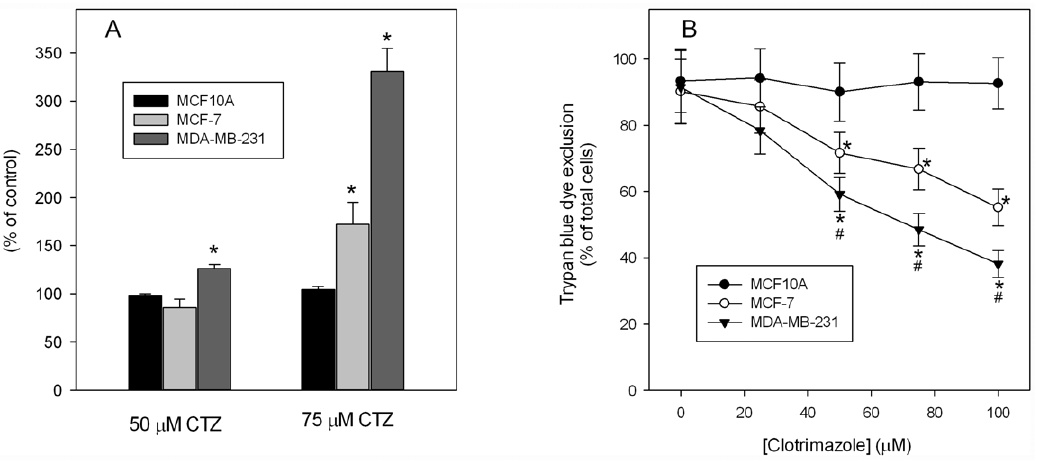
Figure 5. Cellular viability decreases in breast cancer cells treated with clotrimazole. Data are presented as mean 6 SE of at least five experiments. Panel A: lactate dehydrogenase (LDH) leaked to culture medium by clotrimazole-induced cellular lyse was evaluated as described in Methods. * P , 0.05 compared to MCF10A cells in the same clotrimazole concentration. Panel B: the percentages of cells that exclude trypan blue dye were evaluated counting the total cells and those that were intracellularly stained with the dye. Cells were counted using a TC10 Automated Cell Counter (Bio-Rad Laboratories, CA, USA). * P , 0.05 compared to MCF10A in the same clotrimazole concentration. # P , 0.05 compared to MCF-7 in the same clotrimazole concentration.